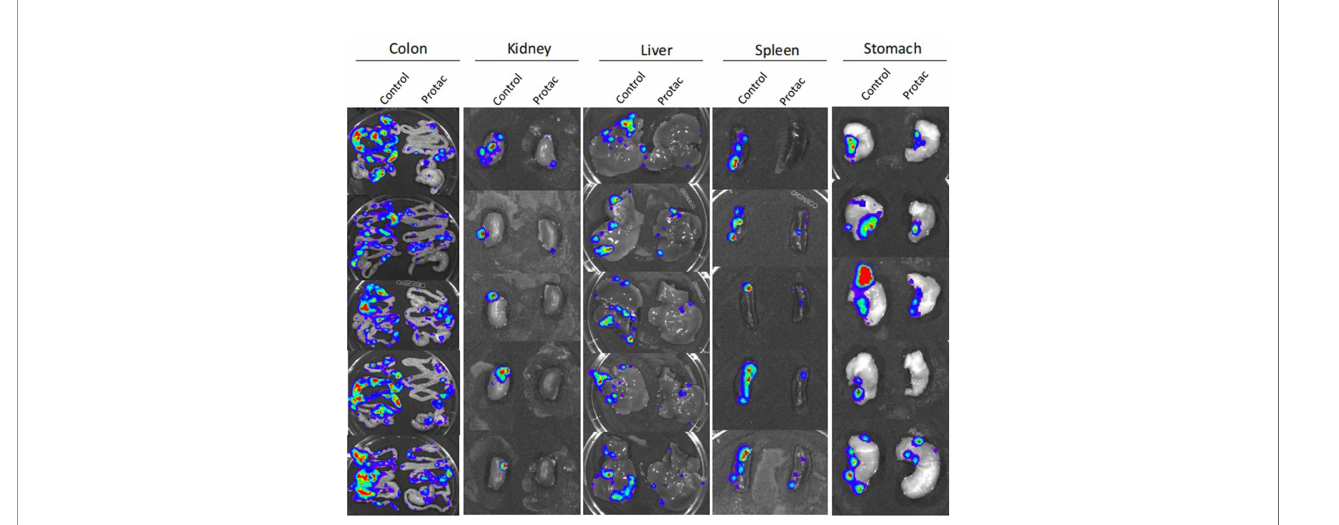
FIGURE 7 | FAK PROTAC inhibits ovarian tumor metastasis. Metastatic tumors in colon, kidney, liver, spleen and stomach were visualized by bioluminescence imaging after three-weeks of FAK PROTAC and vehicle